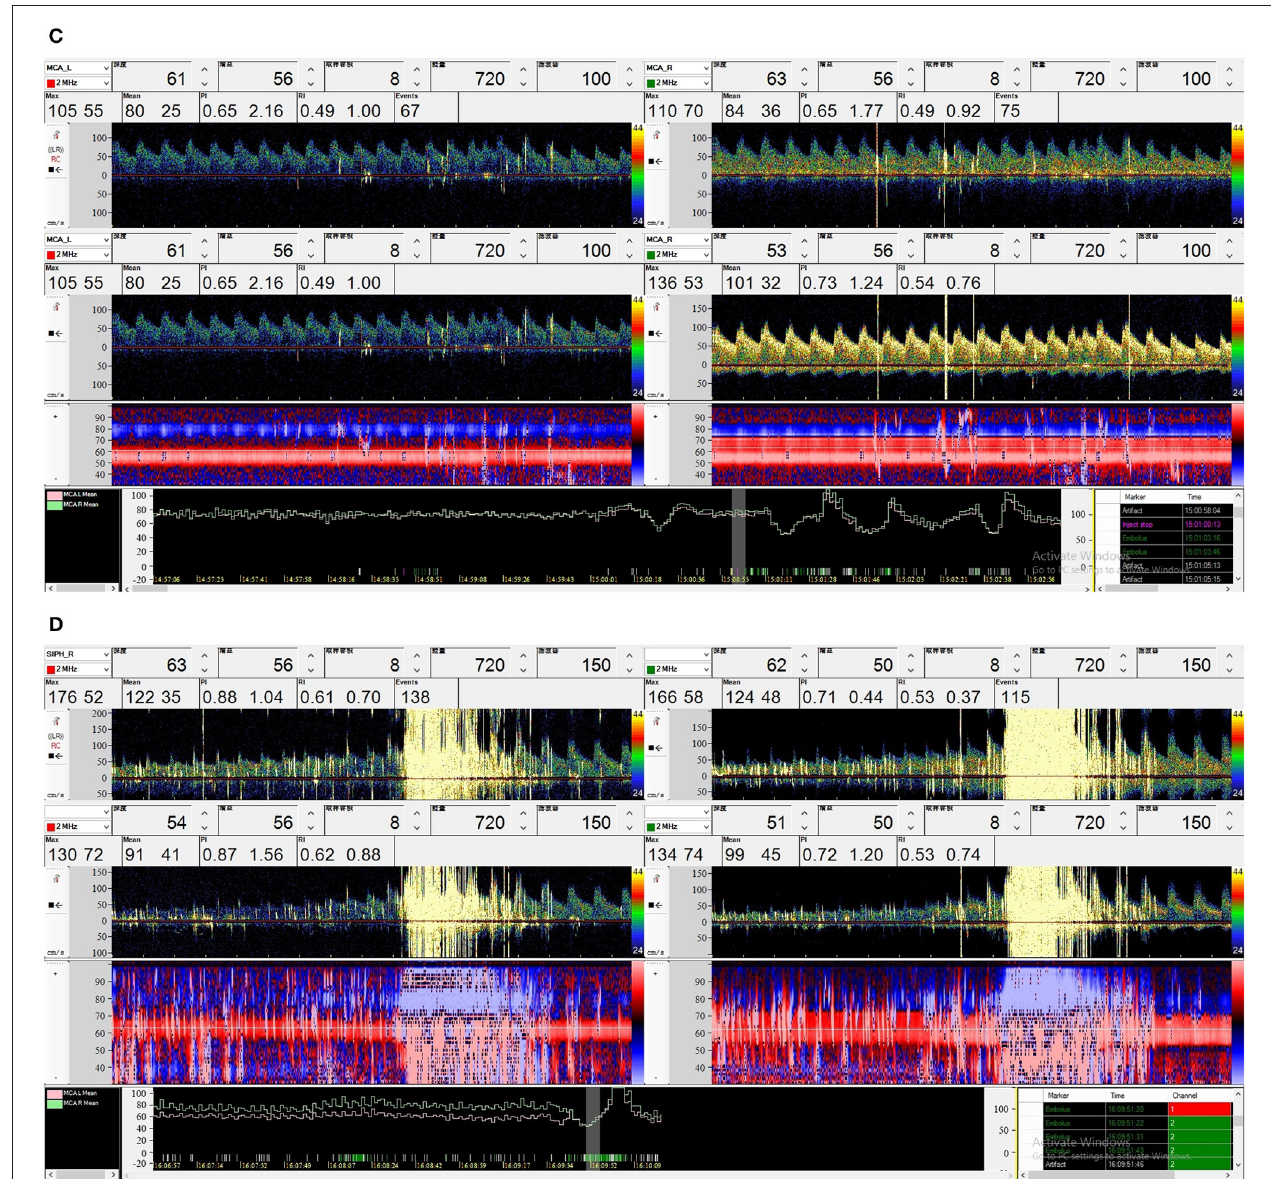
FIGURE 1 | A four-level RLS categorization based on the MB count was applied in our study. (A) None (negative result, 0 MBs); (B) Mild (1 ≤ MBs ≤ 10); (C) Moderate (10 < MBs ≤ 25); (D) Large ( > 25 MBs).